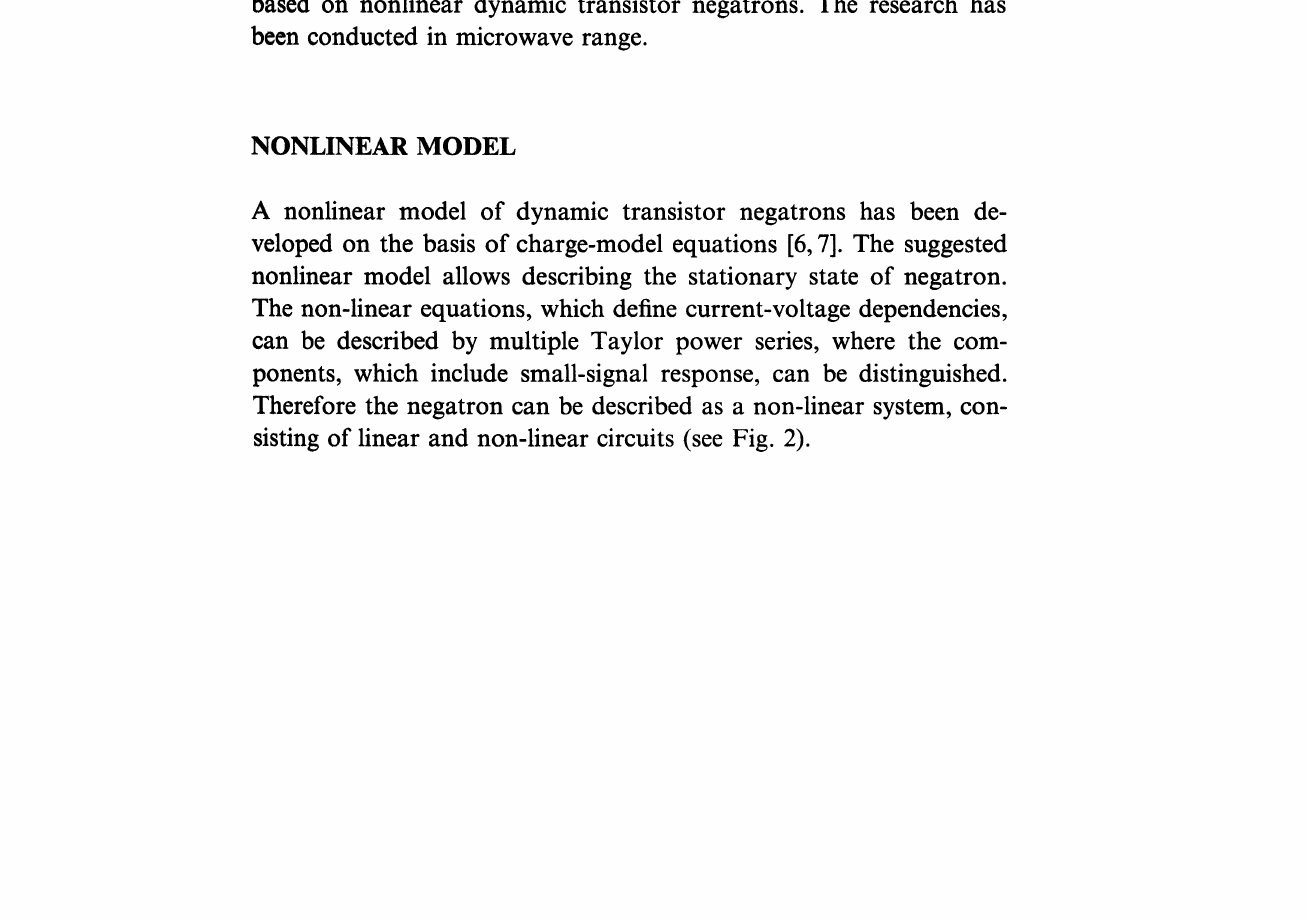
FIGURE lc Time dependence of alternate current and voltage in dynamic